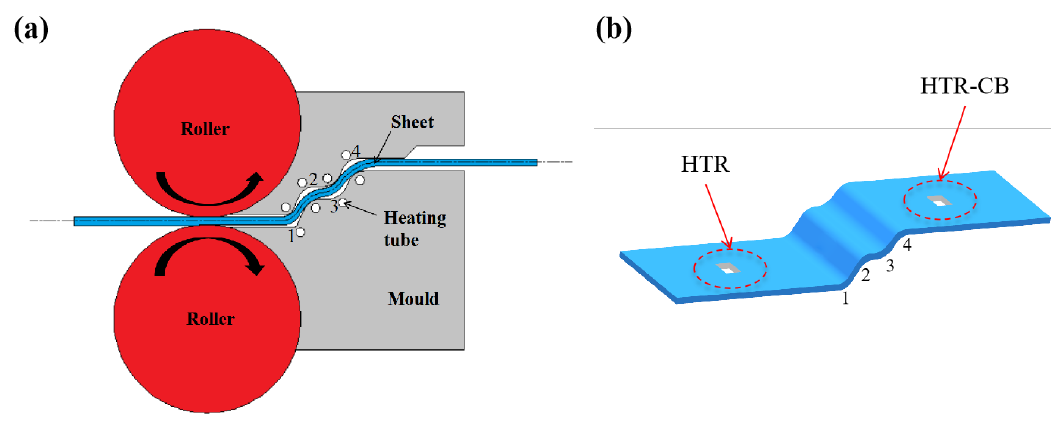
Figure 1. ( a ) Schematic illustration of the high-temperature rolling and continuous bending (HTR-CB) process (bend deformation in corner 1,2, 3 and 4); ( b ) Schematic illustration of the HTR and HTR-CB samples.